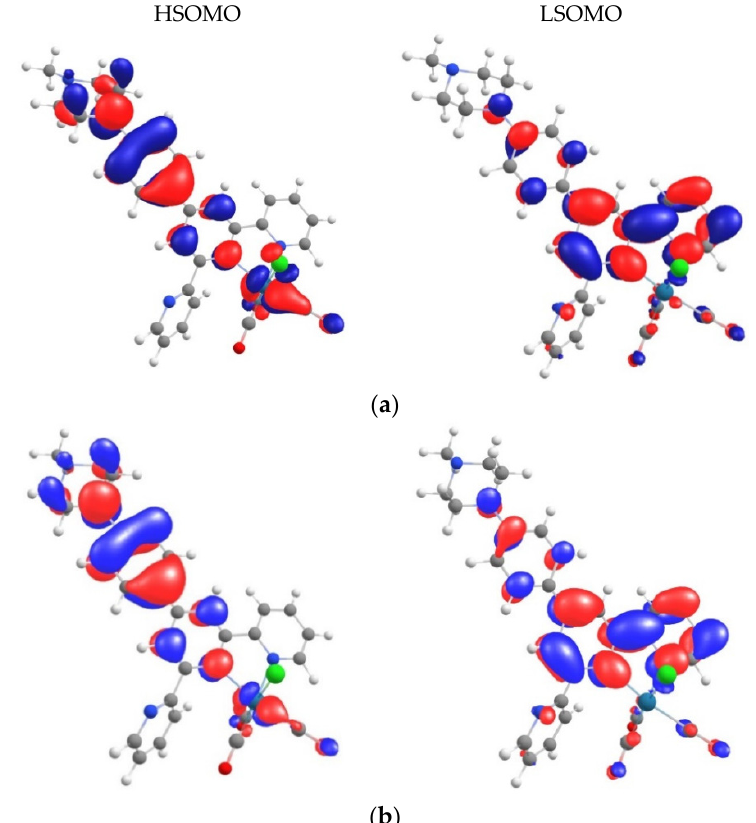
Figure 7. Representative isodensity surface plots of the LSOMO and HSOMO for complex 1 (TD-DFT at T 1 state geometry, red and blue colors show regions of excess α spin density and excess β spin density values, respectively), simulated with the PCM model in chloroform ( a ) and acetonitrile ( b ). For complex 2 , see Figure S34 in ESI.